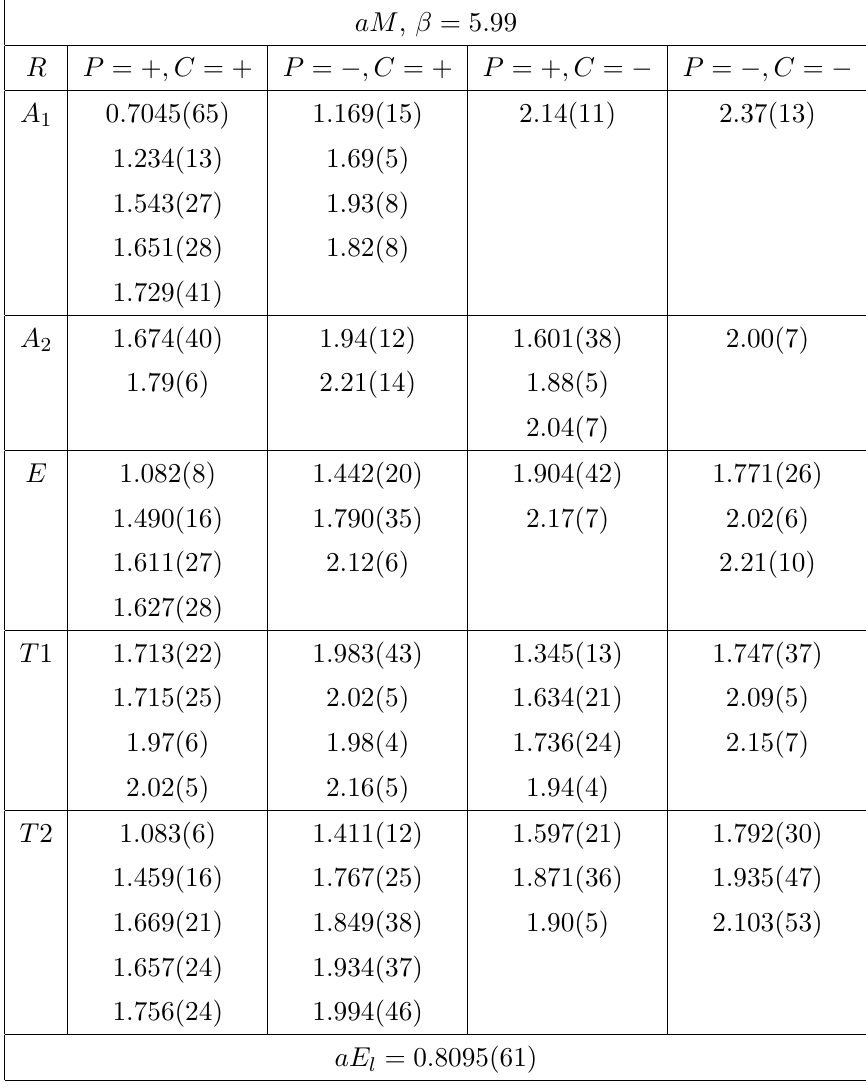
Table 9 . Glueball masses at β = 5 . 99 on a 18 4 lattice for all octahedral representations, R , and for both values of parity, P , and charge conjugation, C . Also the energy E l of a winding flux